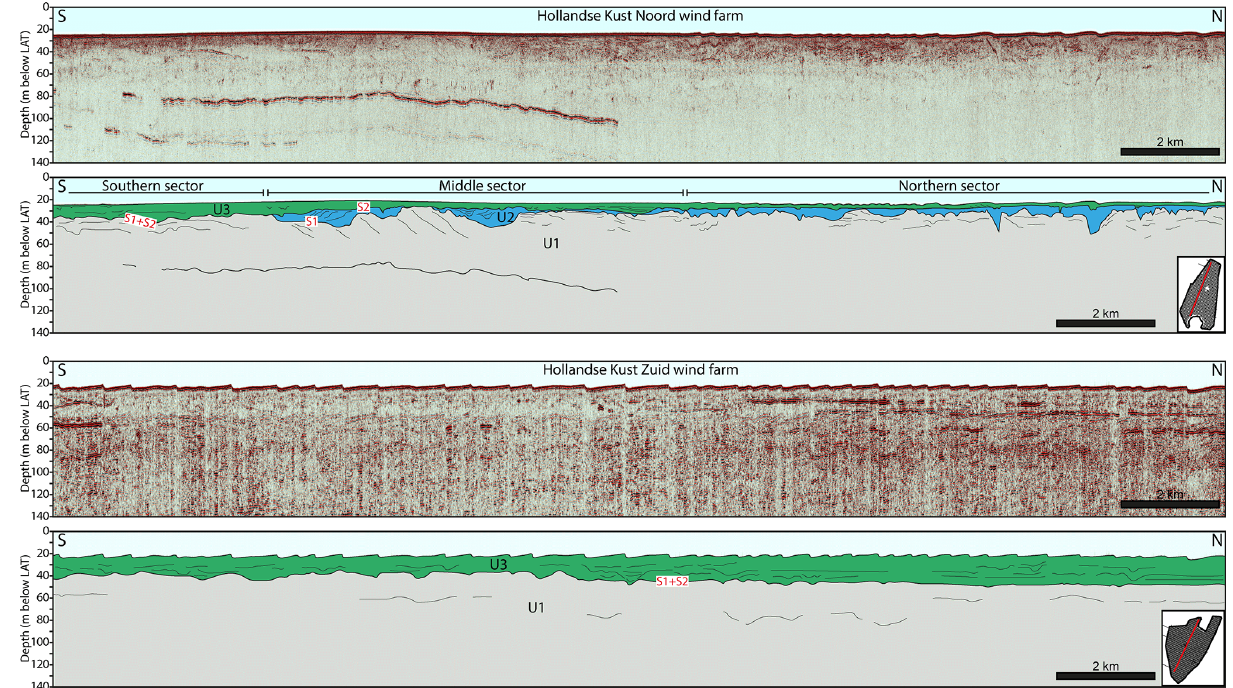
Figure 2. Representative seismic profiles (multi-channel sparker) and interpretation panels across the Hollandse Kust Noord (HKN, above) and Hollandse Kust Zuid (HKZ, below) wind-farm areas showing the main seismic stratigraphic units and surfaces. The separation distance between the northern (HKN) and southern (HKZ) profiles is 17km. For the location of the seismic profiles see the inset maps. Depth is in metres below the lowest astronomical tide